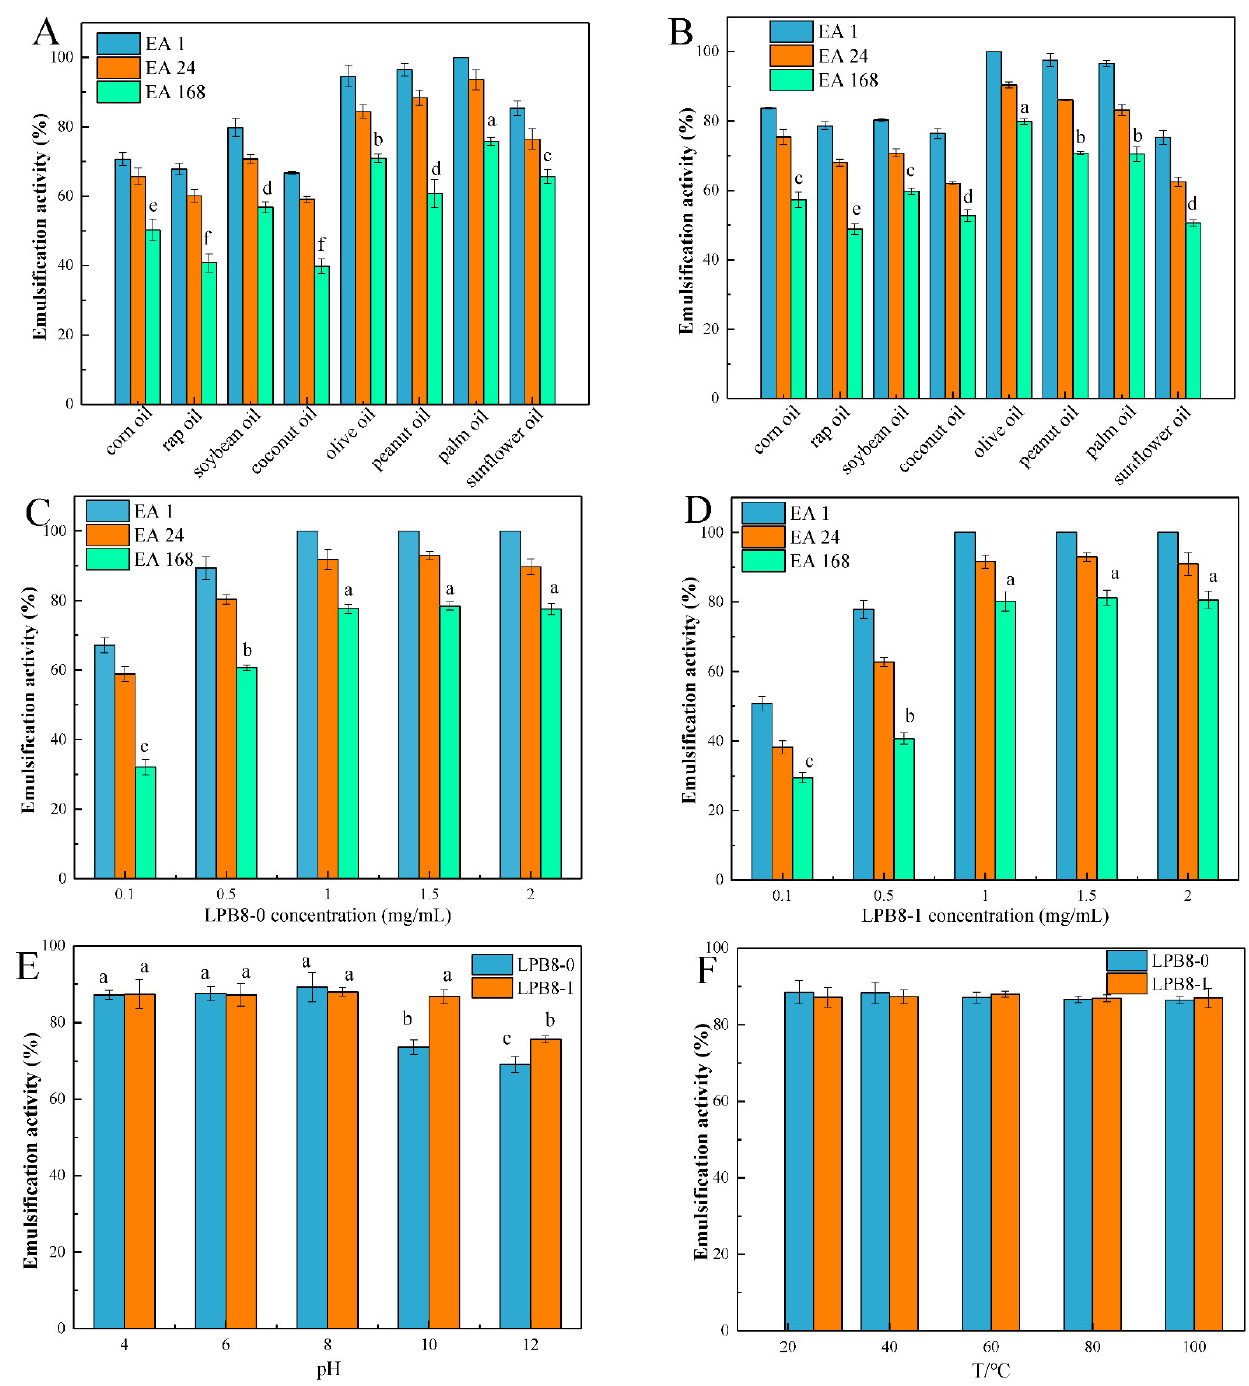
Figure 6. Emulsification activity of emulsions prepared with different oils ( A , B ) and different LPB8-0 and LPB8-1 concentrations ( C , D ); influence of pH ( E ) and temperature ( F ) on the emulsification activity of the emulsions. Statistical differences are indicated with different lowercase letters ( p < 0.05).